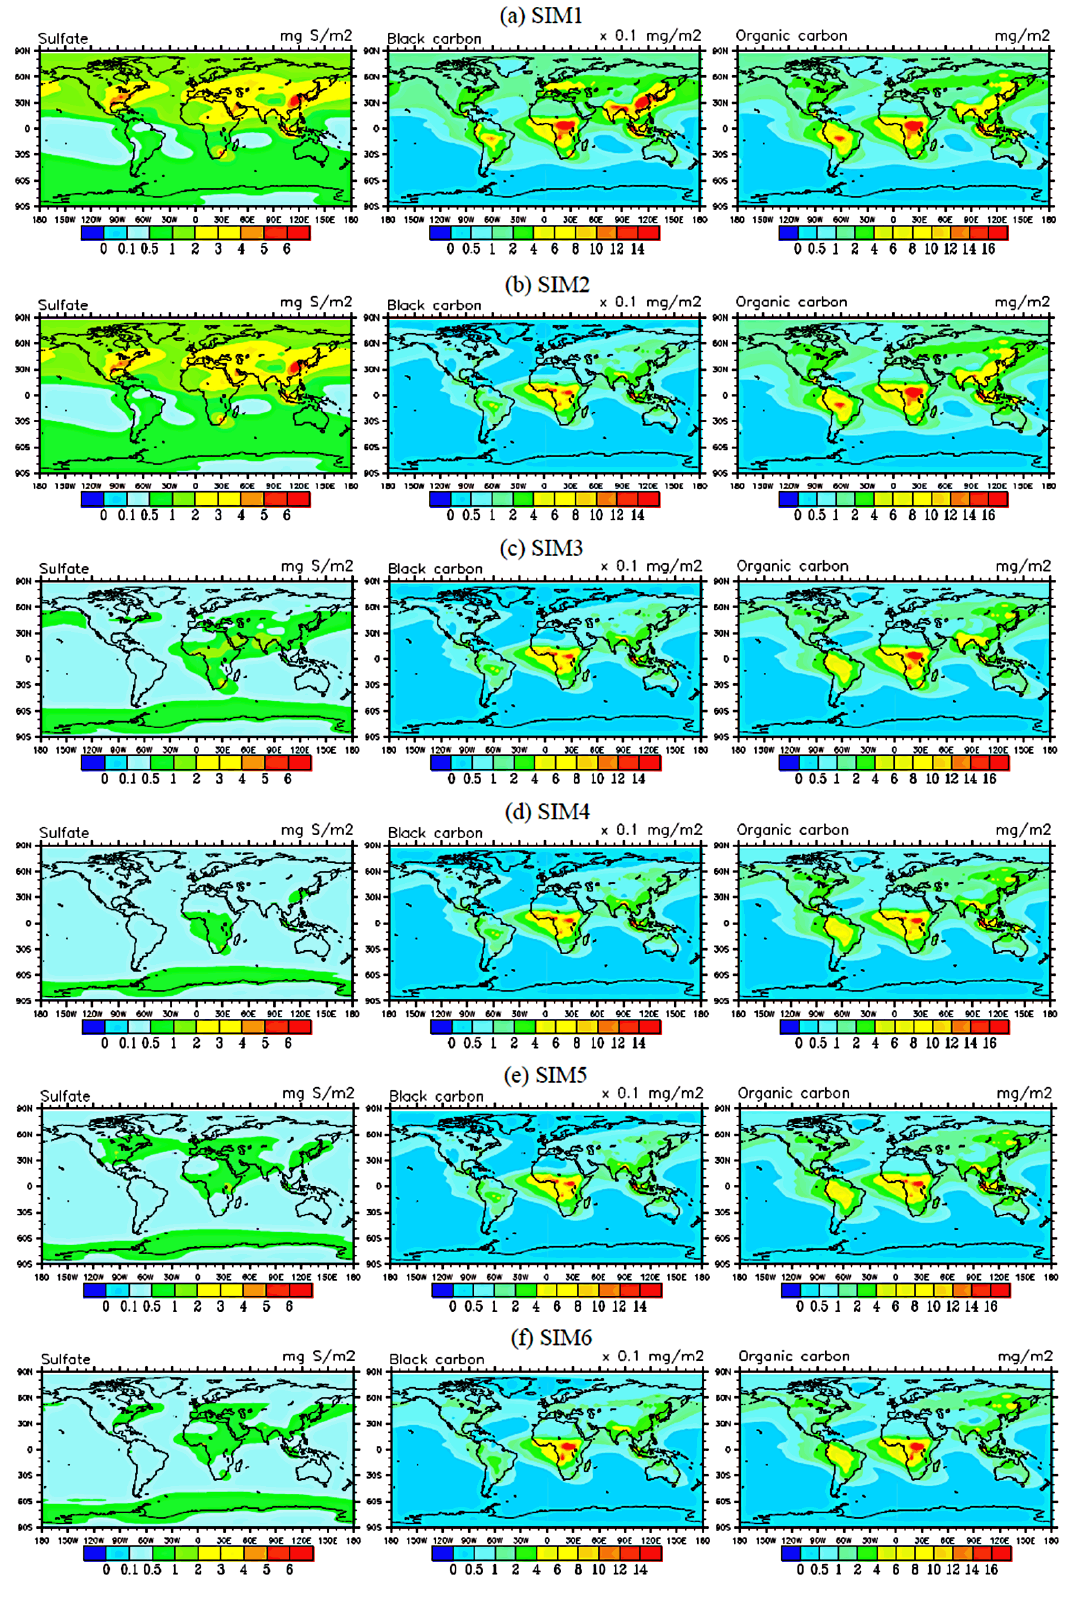
Figure 2. Global distributions of simulated annual mean aerosol column burdens (units: mgm − 2